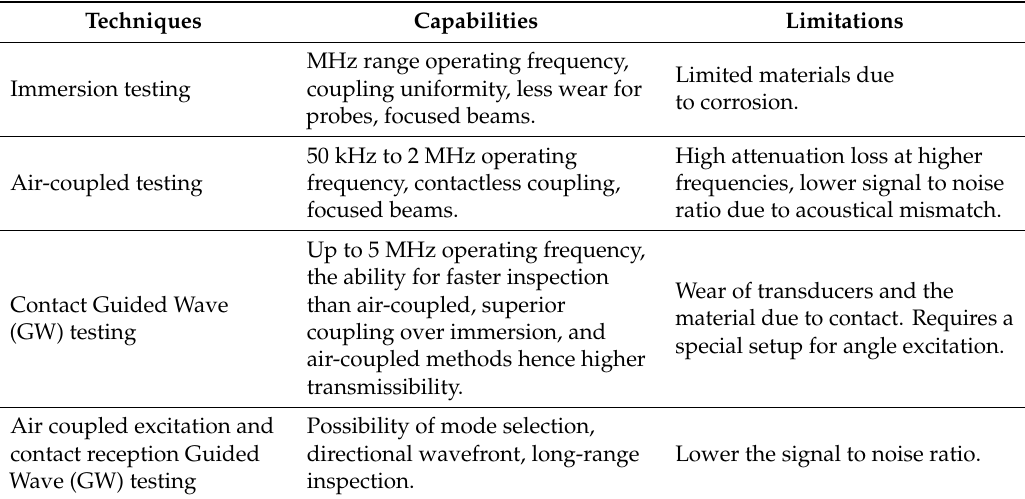
Table 1. Comparison of di ff erent techniques.